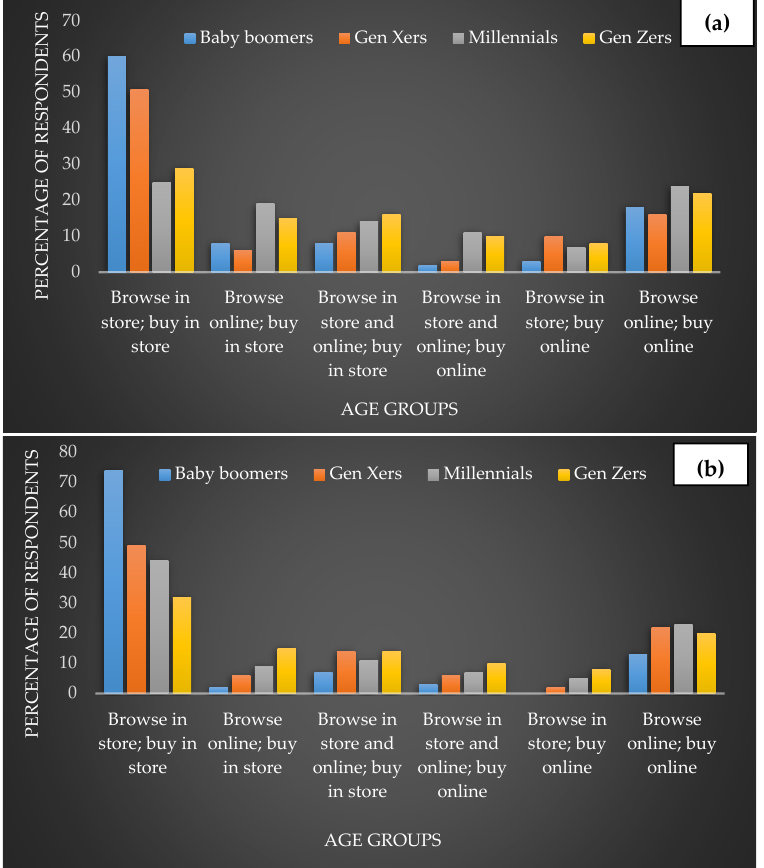
Figure 1. Assessment of in-store and online sales for cosmetic ( a ) and skin care ( b ) products according to different age groups (Baby boomers, Gen Xers, Millennials, Gen Zers); source, McKinsey new